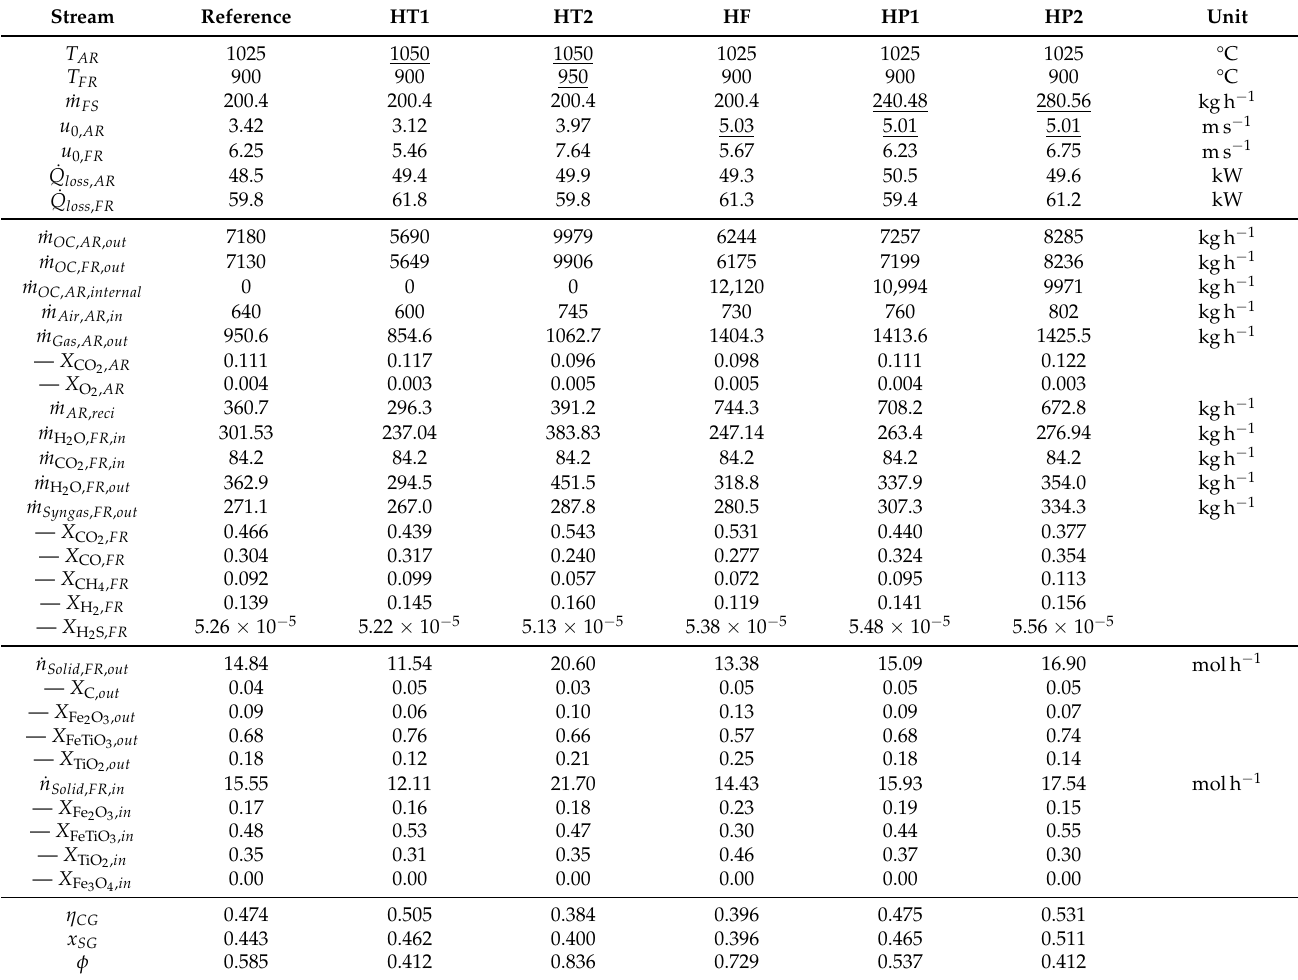
Table 4. Simulation results for autothermal CLG operations of the 1MW pilot plant. Stream names correspod to Figure 2. Boundary conditions deviating from the reference case are underlined. The first block contains the thermodynamic and hydrodynamic constraints and results, the second block contains the process streams (in some cases with compo- sition). The third block gives information on solid composition for the FR, while the last block shows general process performance